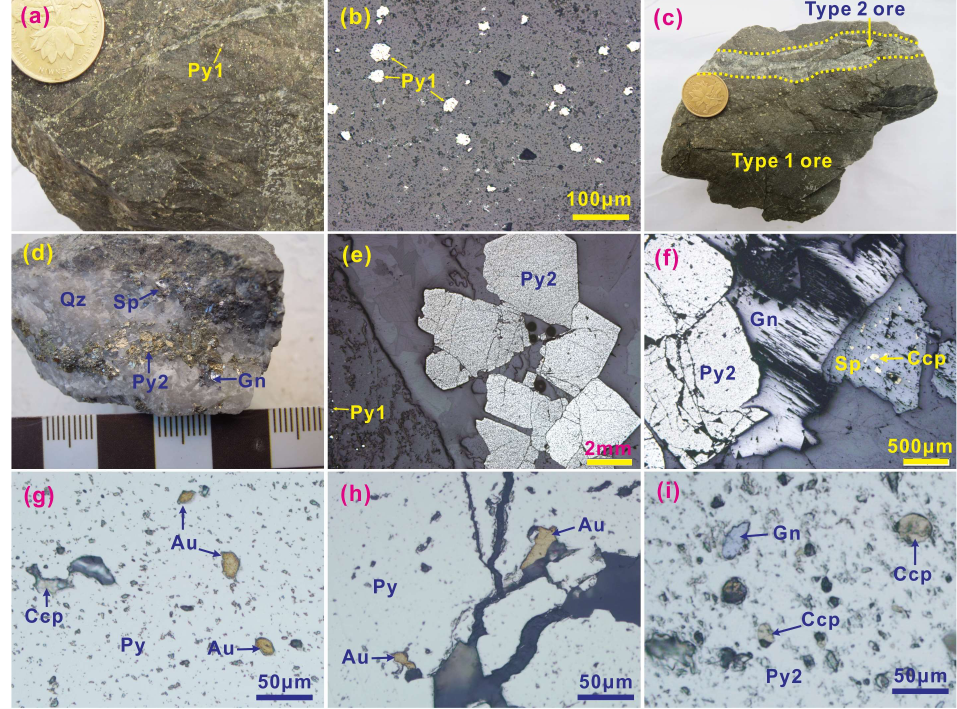
Figure 3. Hand-specimen photographs and reflected-light ore petrography of the Huanxiangwa gold deposit. ( a , b ) Fine-grained anhedral pyrite (Py1) disseminated in altered rocks; (c ) auriferous quartz vein (type 2 ore) cross-cutting disseminated ore (type 1 ore); ( d – f ) coarse-grained, subhedral-euhedral pyrite (Py2) in an auriferous quartz vein; ( g , h ) native gold and electrum in fractures or as inclusions in pyrite; ( i ) chalcopyrite and galena inclusions in Py2. Type 1 ore—disseminated ore; Type 2 ore—auriferous quartz vein; Py—pyrite; Py1—pyrite disseminated in altered rocks; Py2—pyrite hosted in auriferous quartz veins; Ccp—chalcopyrite; Gn—galena; Sp—sphalerite; Au—visible gold; Qz—quartz.